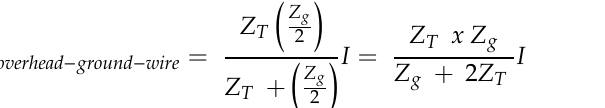
Figure 8. Voltage across the insulator following a lightning strike to the phase conductor (lightning current wave shape = 4.12/77.5 μs, lightning current = 40 kA); ( a ) Strike to the middle of the phase conductor; ( b ) Strike to the end of the phase conductor.